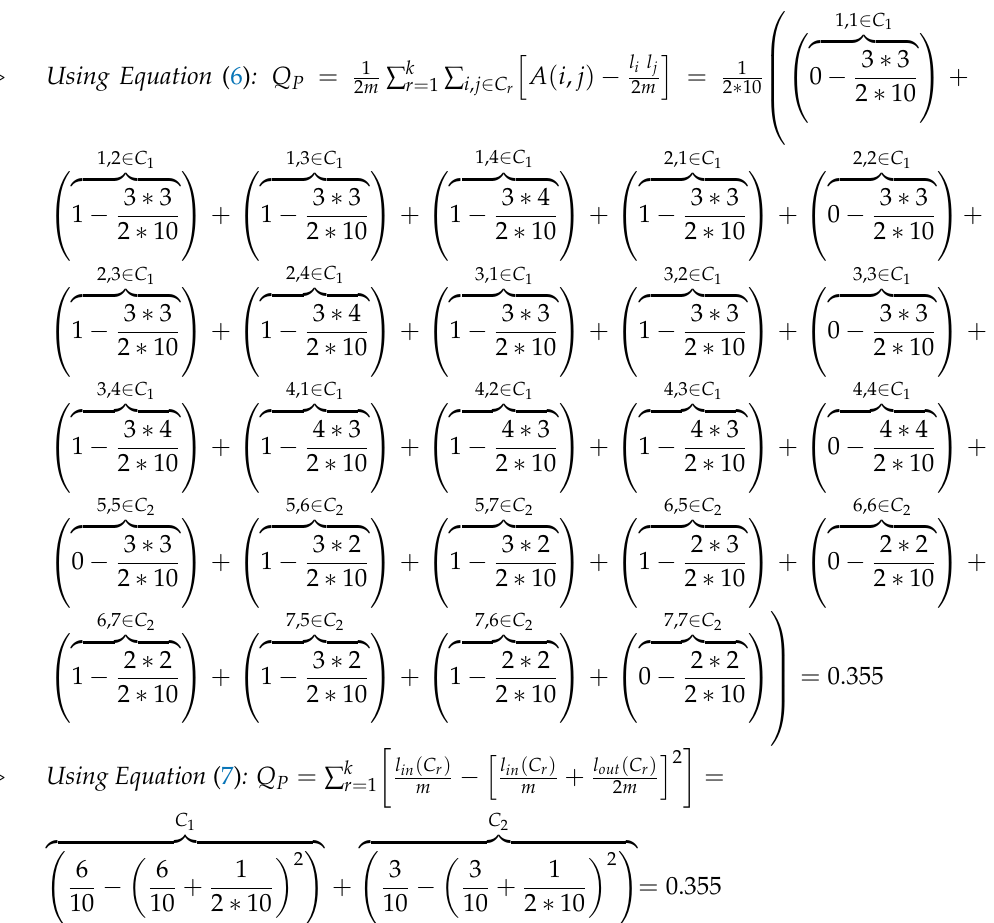
Figure 2. Graph G = ( N , E ) with 7 nodes, and the considered partition, P = {{ 1,2,3,4 } , { 5,6,7 }} .